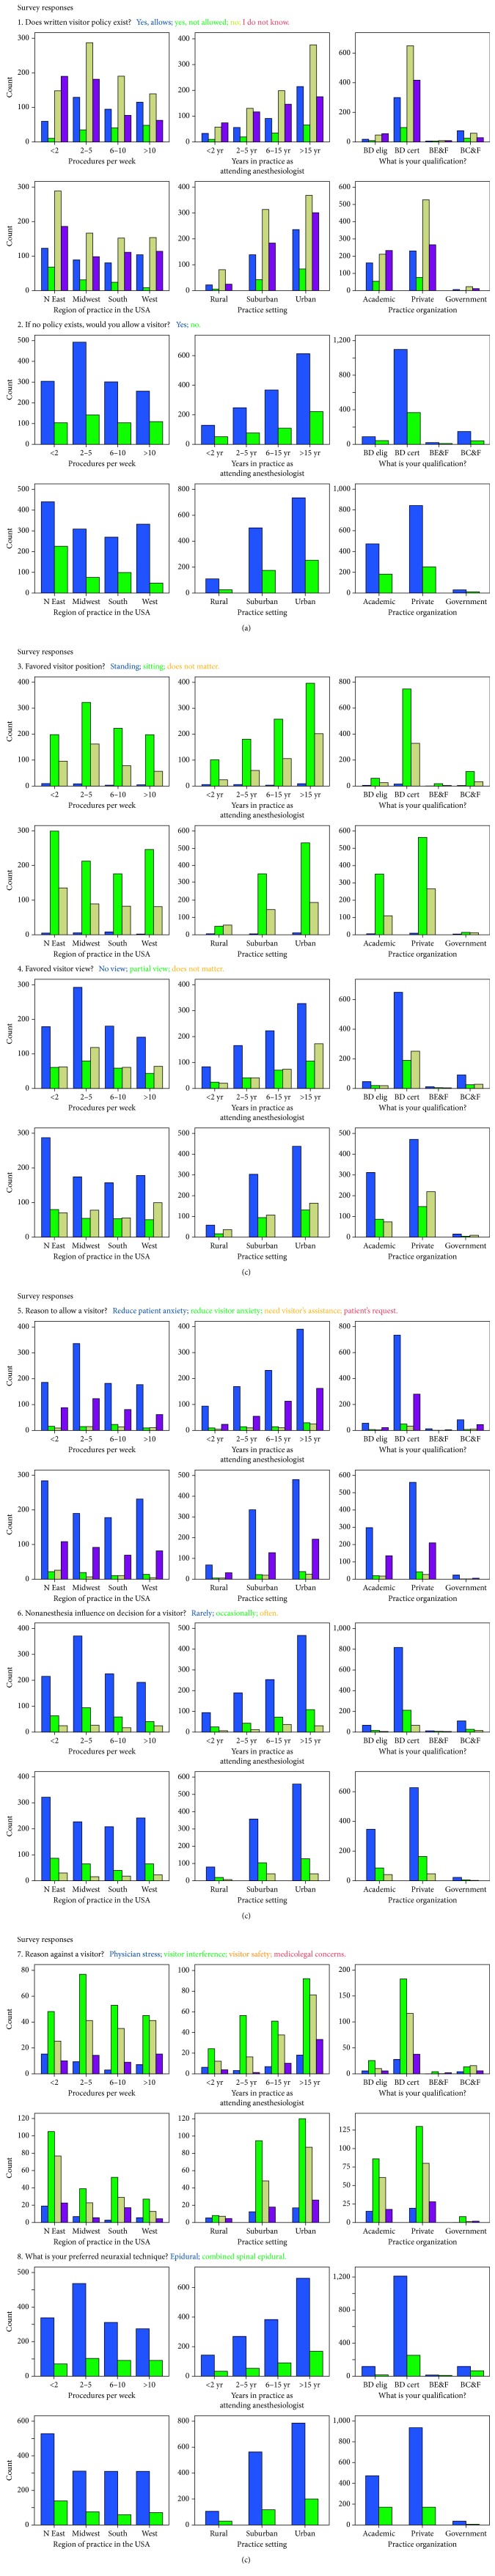
Detailed analysis of the distribution of responses to eight survey questions by the six categories of physician responders.